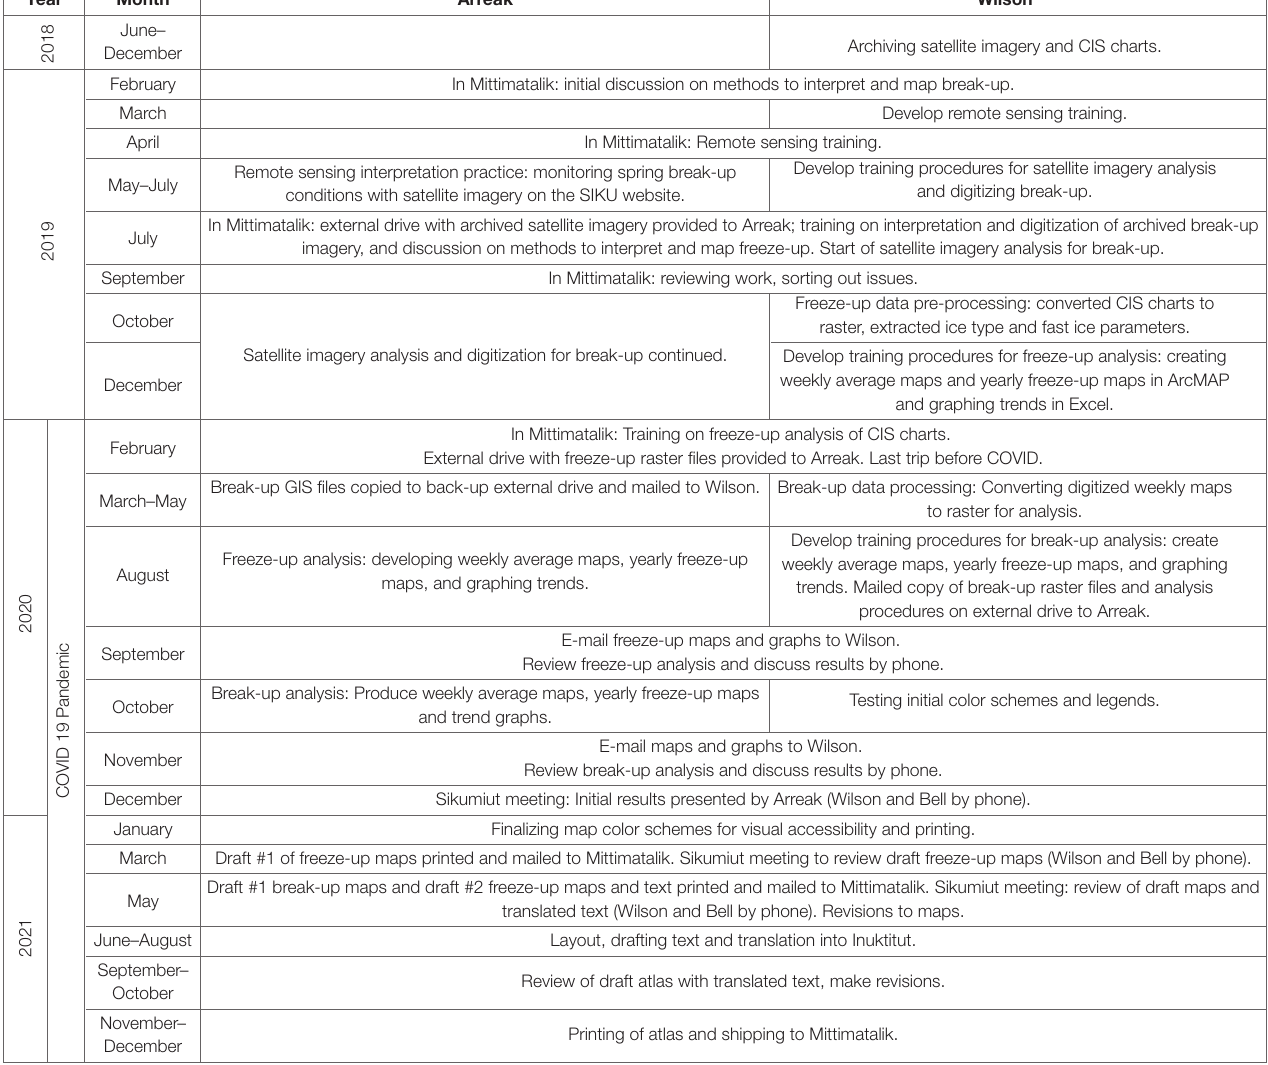
TABLE 2 | Mittimatalik sea ice atlas co-production timelines and